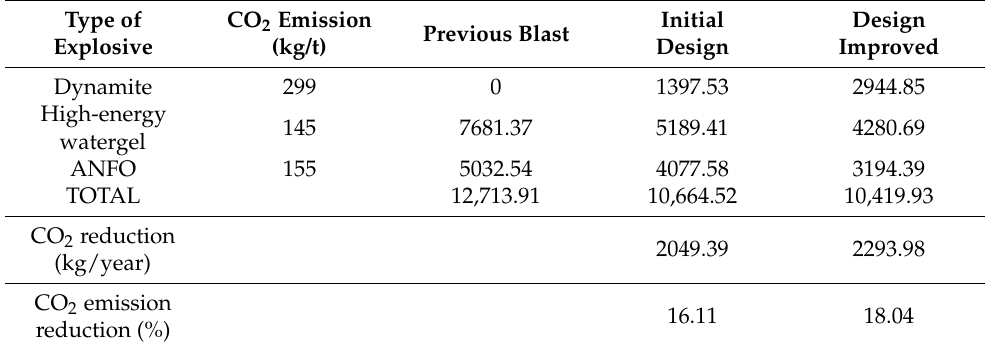
Table 11. Annual CO 2 emission and comparison between types of